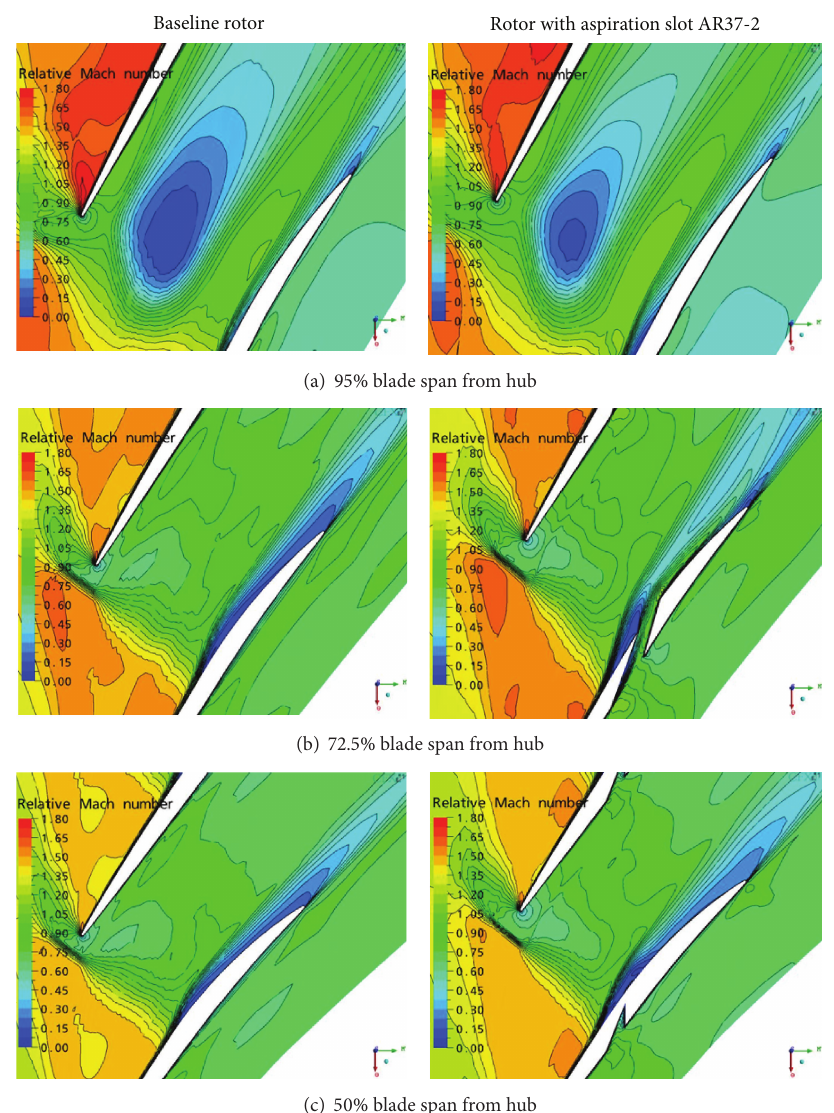
Figure 16: Mach number distribution in the rotor blade passage without and with aspiration (AR37-2 slot) at three spanwise locations from hub (100% design rotational speed, near-stall mass flow